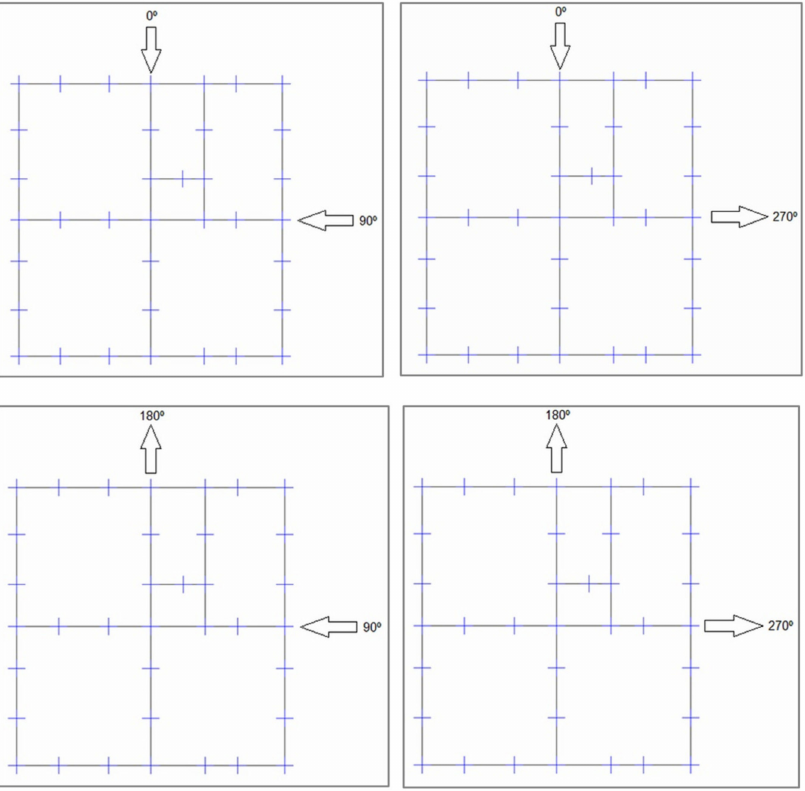
Figure 19. The four load application configurations in SHS Embryo 2C’s footprints